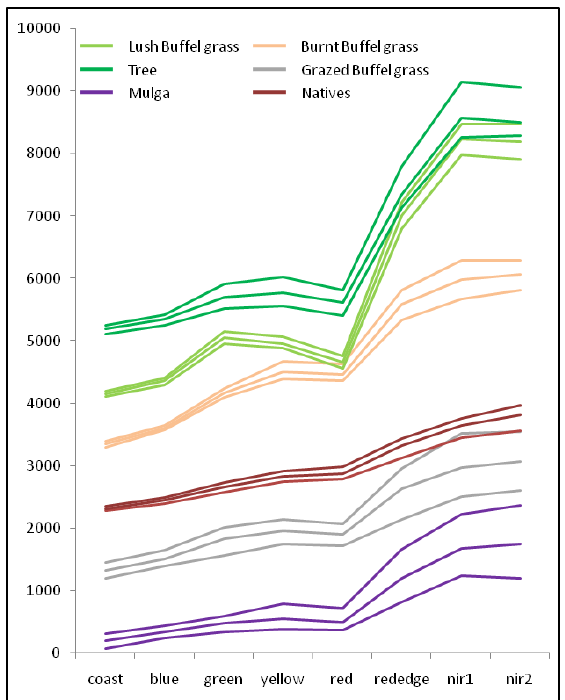
Figure 4: Mean, Maximum and Minimum reflectance (nm) for each spectral group collected from Worldview-2 scene obtained 22 Jan 2011 over a 10x10km area 1km west of Alice Springs, Australia. Each spectral grouping is offset by 1000nm. Spectral groups include Lush Buffel grass, Tree, Mulga, Burnt Buffel grass, Grazed Buffel grass and